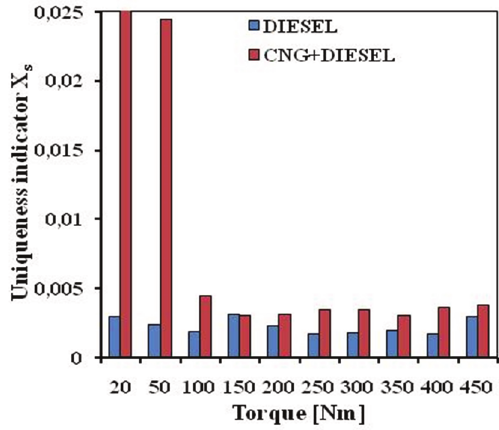
Fig. 13. Comparison of the value of the uniqueness indicator for the indi- Fig. 10. Comparison of the value of the uniqueness indicator for the mean cator diagram for the Perkins 1104D-E44TA engine, operating according indicated pressure of the Perkins 1104D-E44TA engine operating accord- ing to external speed characteristics, in dual-fuel operation powered by CNG + Diesel and by diesel fuel only